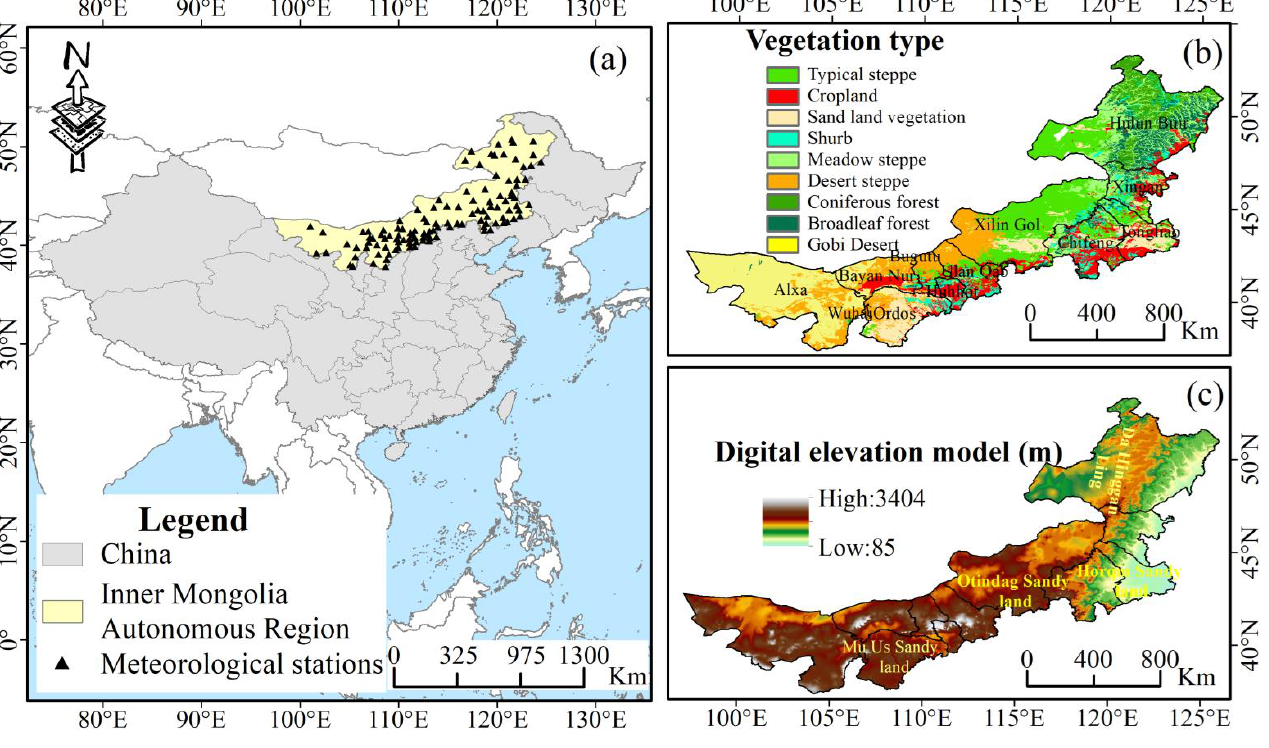
Figure 1. Overview of the study region, ( a ) Geographical location and meteorological stations, ( b ) Vegetation types, and ( c ) Digital elevation model (DEM).